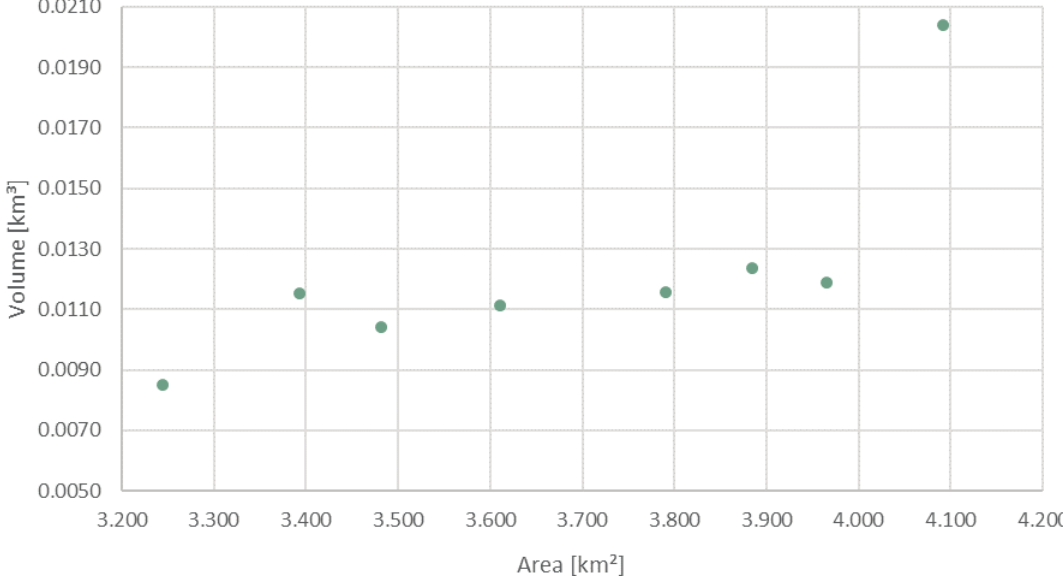
Figure 4. Comparison of the flooded area and the water retention volume for certain days of the simulated flood event in 2013.